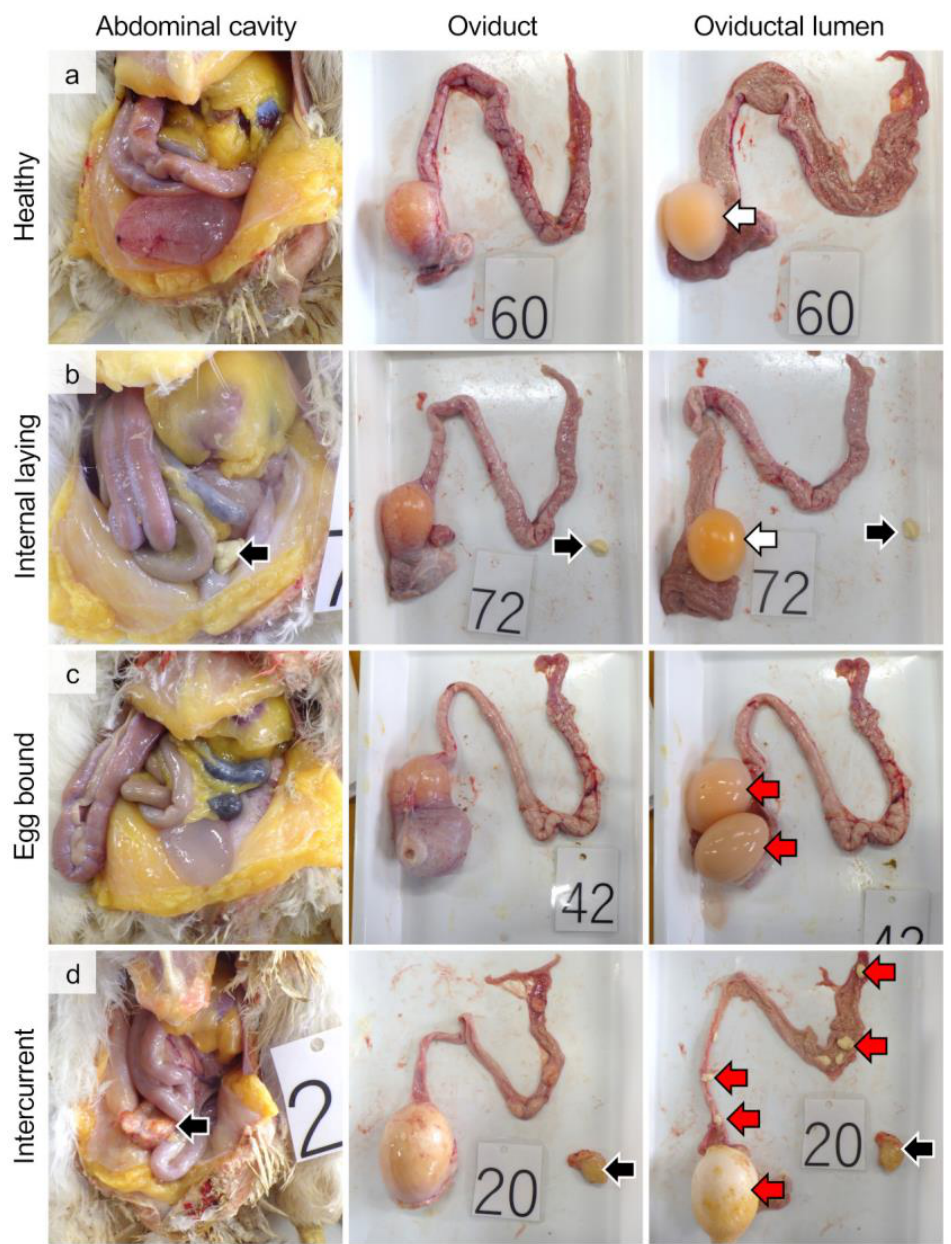
Figure 1. Gross images of abdominal cavity, oviducts, and oviductal lumen of laying hens divided into the groups of healthy ( a ), internal laying ( b ), egg-bound ( c ), and intercurrent ( d ). White arrows: one egg in the uterus. Black arrows: eggs escaped into the abdominal cavity. Red arrows: two or more eggs stagnating into the oviduct. To reveal the metabolic conditions related to eggshell production and oviductal mus- cular peristalsis, we analyzed the serum calcium level in the laying hens; however, there were no significant differences among the groups (Figure